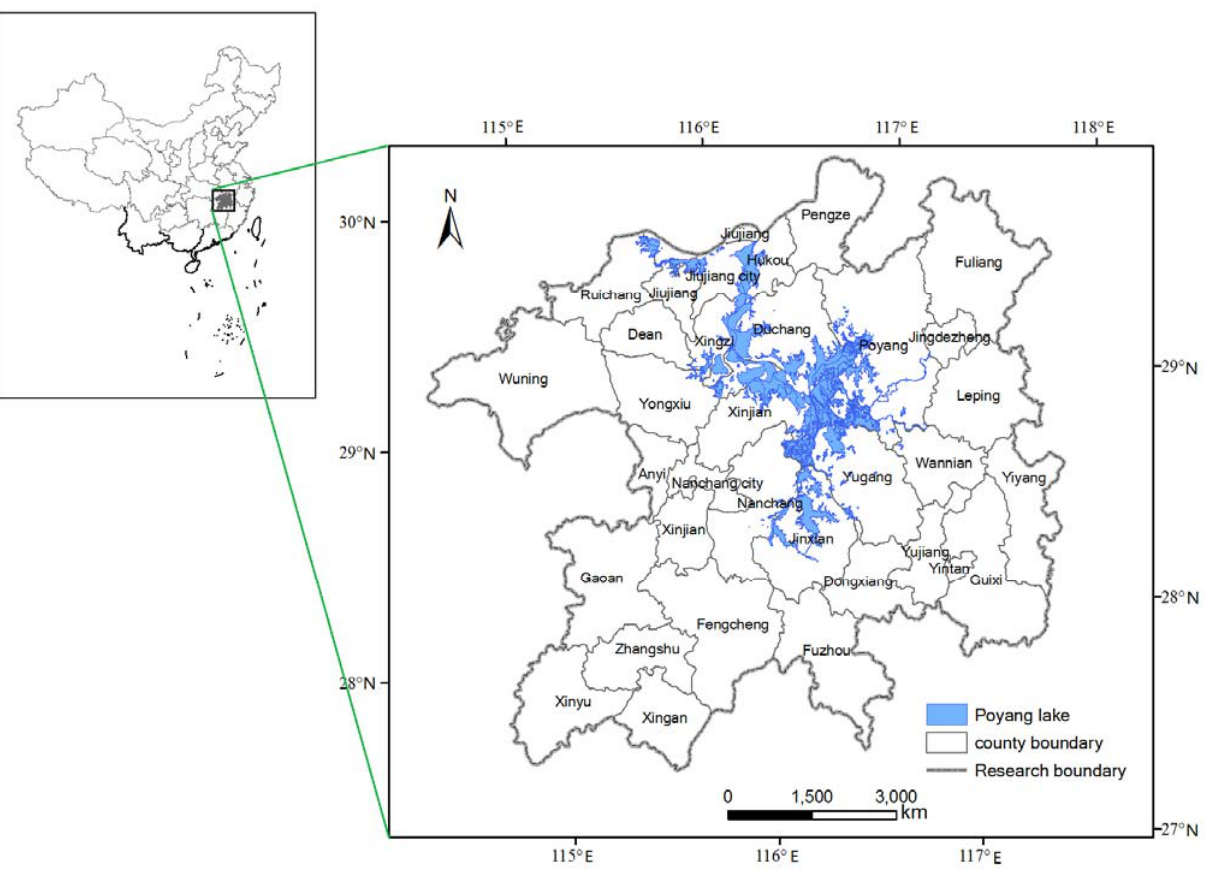
Figure 1. Map of the location of the Poyang Lake Eco-economic Zone in